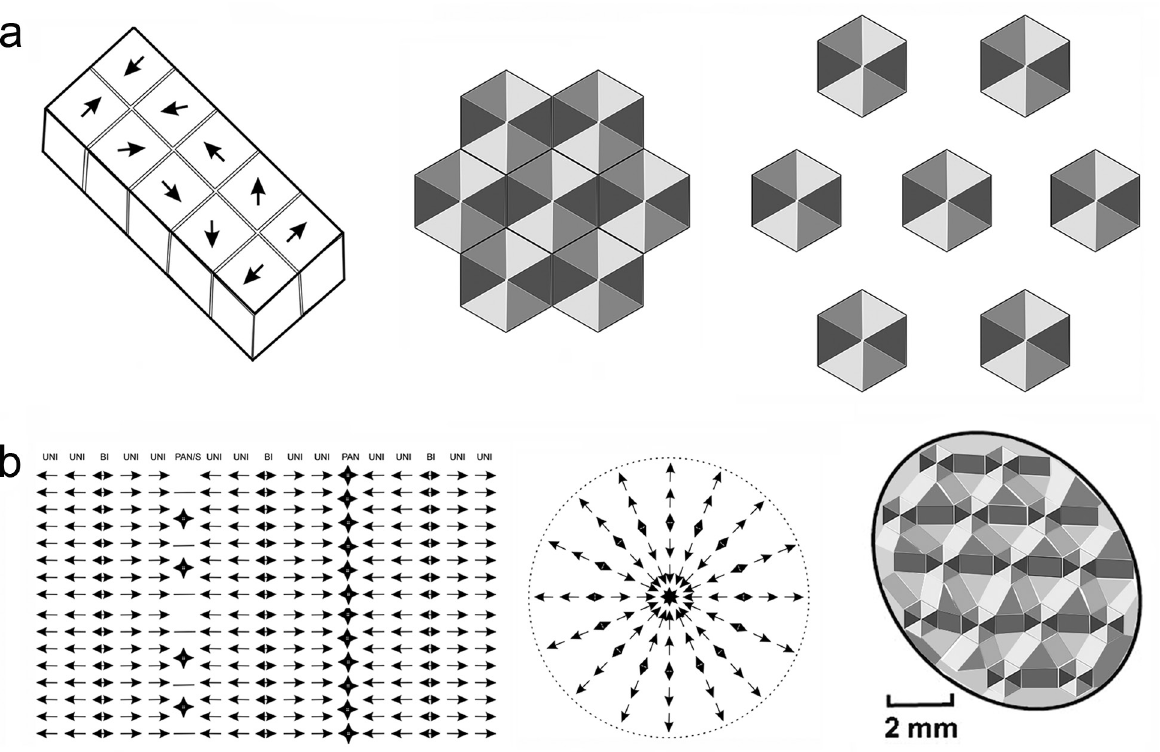
Figure 6. A model for the combined arrangement of cell type and directional selectivity in the surface dimension of area MT. (a) Left : The ice-cube model proposed by Albright et al (1984), where columns with opposing directional selectivity are organized into larger modules coding for axis of motion. This model assumes a smooth transition of direction selectivity across MT surface, with occasional 180-degree flips. Middle : Subsequent work by Diogo et al (2003) suggests that smooth transitions in direction selectivity coexist with singularity points (i.e., pinwheels). The pinwheels are actually more sparsely distributed across MT surface than initially expected, with relatively large intervening slabs coding for the same direction (right). Different shades of gray represent regions with different axis of movement selectivity. (b) Left : a modified model relative to the one illustrated in (a), where bidirectional and pan-directional modules are incorporated. Middle : A model that incorporates pinwheels and direction selectivity columns. Right : A unified model that incorporates pinwheels, direction selectivity columns and elongated regions on MT surface coding for axis of